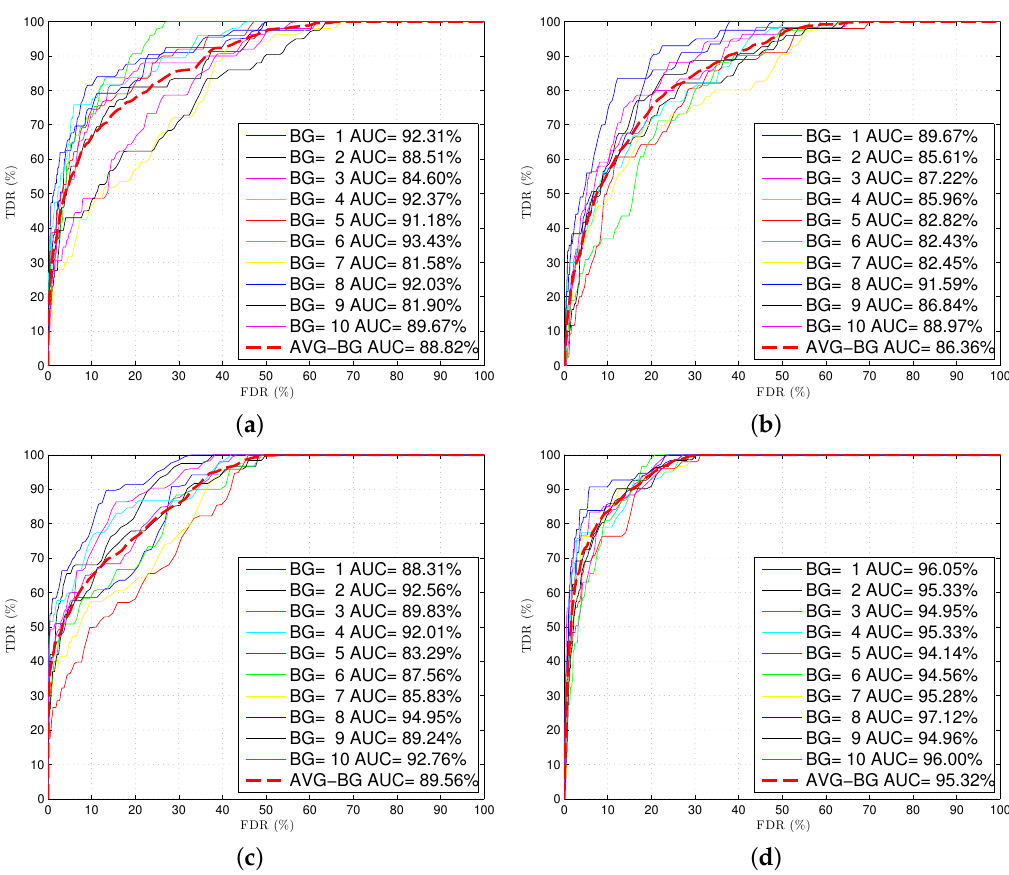
Figure 8. ROCs for the best achieved results with each background model. The red dotted line represents the overall mean curve. ( a ) AMPds gas; ( b ) AMPds water; ( c ) overall gas; ( d ) Whitehall House water. Table 6. Best results’ details. TDR, True Detection Rate; FDR, False Detection Rate; BG, Background. The Whitehall set is reported as